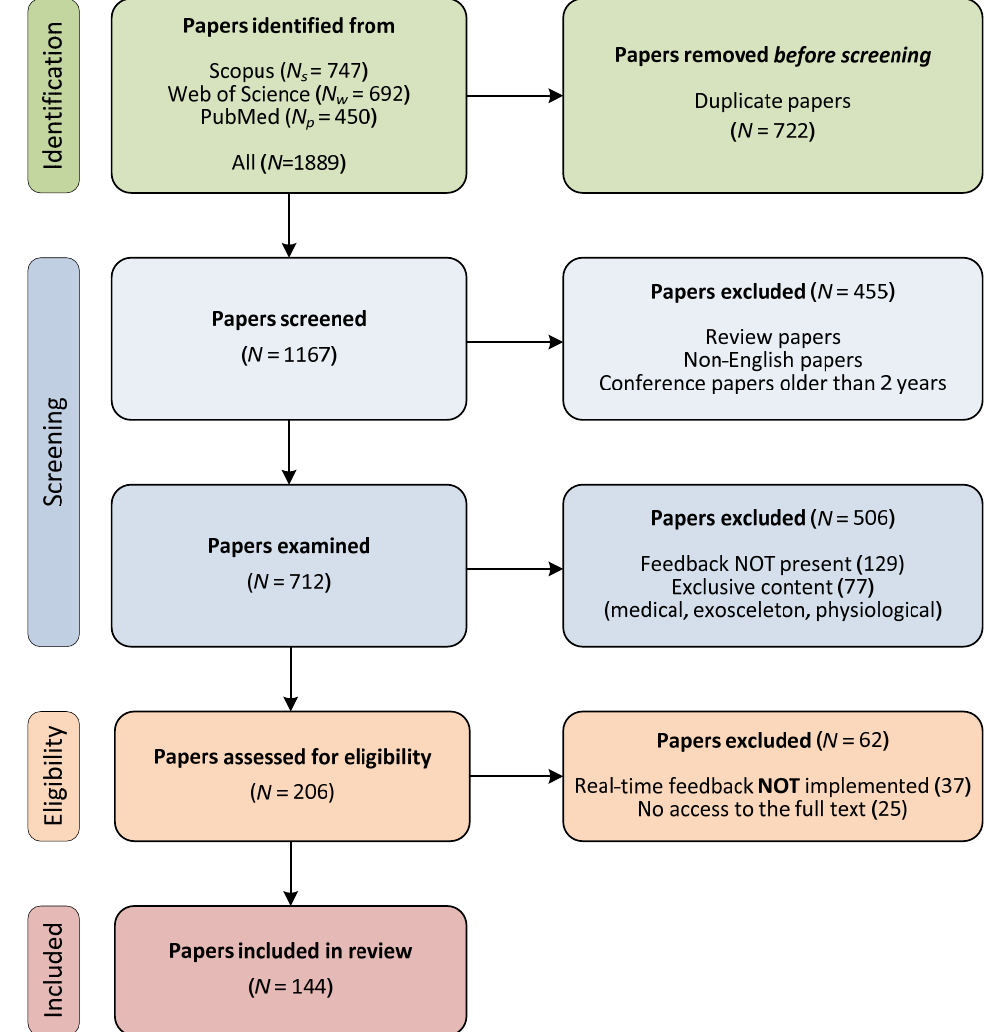
Figure 2. Results of database search and the selection of papers. A total of 1889 papers were found in the three databases searched, 1167 unique papers were screened and 144 of them were finally included in the review.